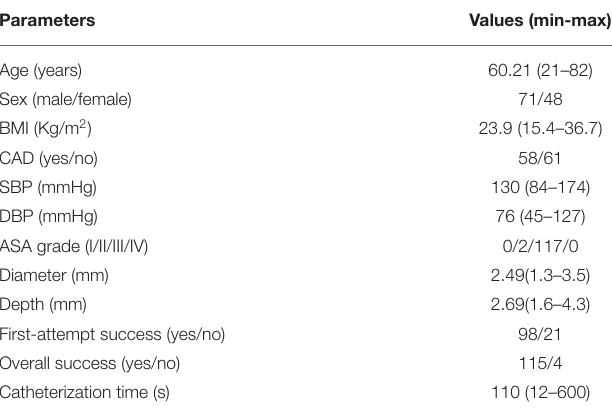
TABLE 1 | Demographic characteristics and catheterized information.